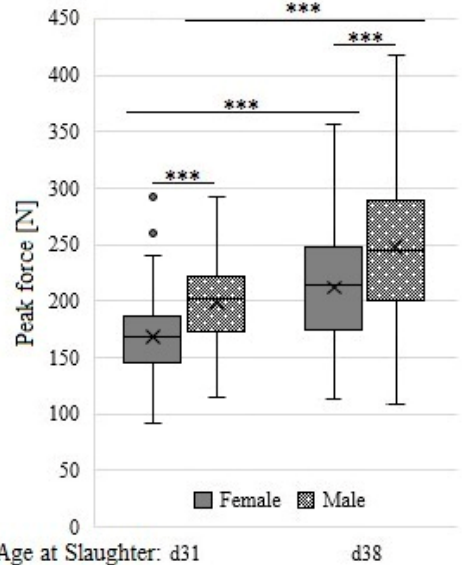
Figure 5. Effect of the interaction between sex (females presented in gray, males presented with patterns) and age at slaughter (day 31, day 38) on measured peak force of the tibiotarsus (N = 445). Results are presented as boxplots (data range, median, lower quartile, and upper quartile; outliers are included in the graph as dots); significant differences between sex and age are marked by asterisks: *** p < 0.001 (Tukey–Kramer tests).